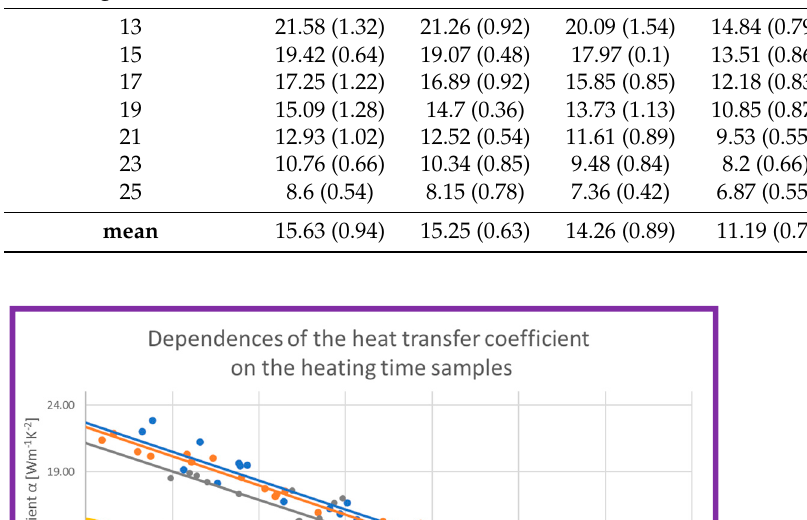
Table 3. Results of the linear regression test.